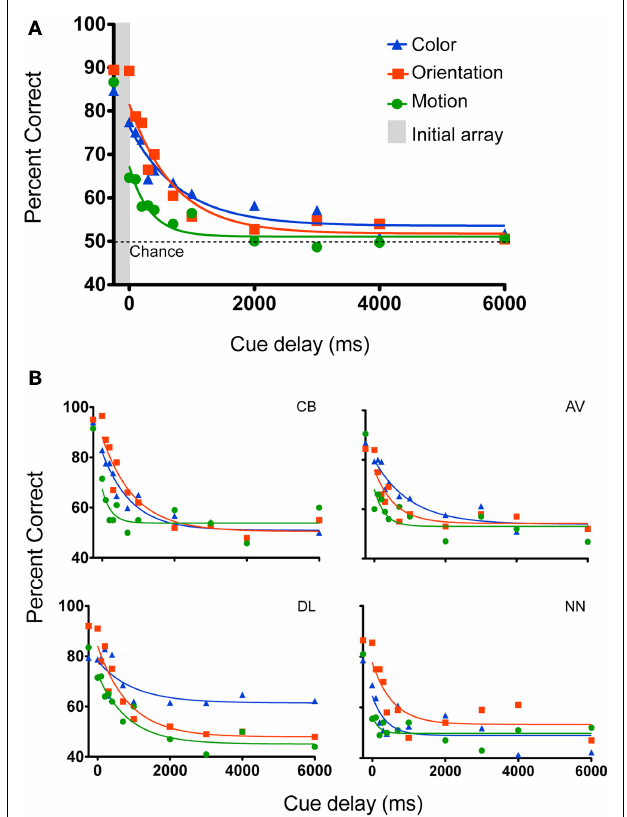
FIGURE 2 | Experiment 1 tested memory for color, form, and motion for the following cue delays after stimulus offset: (simultaneous, 0, 100, 200, 300, 400, 700, 1000, 2000, 3000, 4000, 6000ms). (A) Mean data. The points within the gray vertical bar show performance when the cue was presented during the initial array. An exponential-decay function was fit to the data. Performance declined over time and was worse for motion than for color or orientation. (B) Individual subject data, curves represent best-fitting one-phase exponential-decay functions.